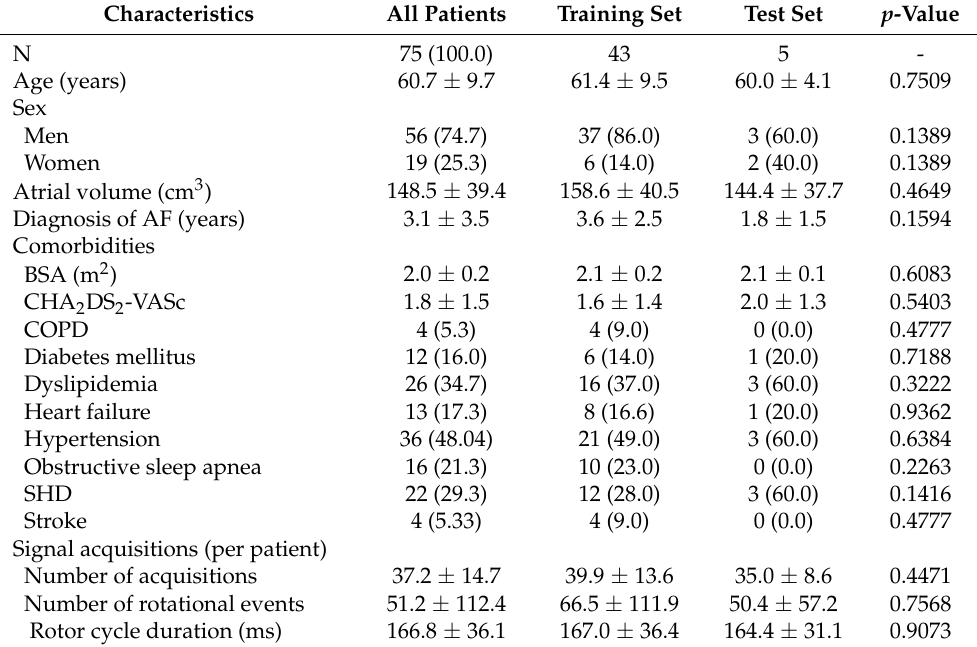
Table 1. Baseline characteristics of the patients.